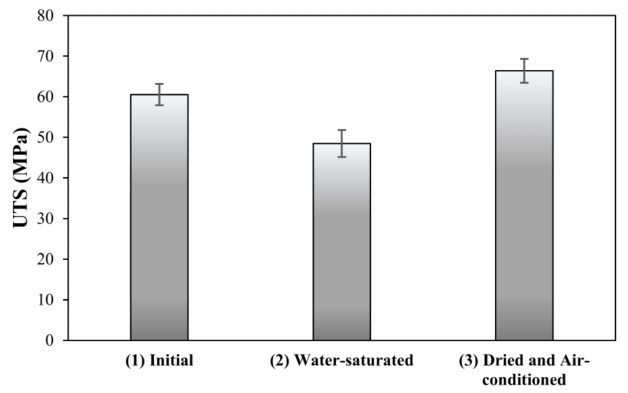
Figure 2. Water-induced drop in ultimate tensile strength (UTS) of amine-cured epoxy resin.